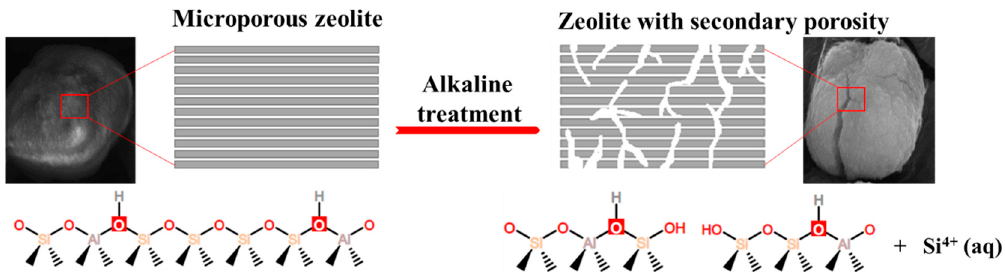
Figure 1. Method of desilication by alkaline treatment (SEM image of the ZSM-5 sample performed in TESCAN equipment, model MIRA3 FEG-SEM, magnification 2 µm).